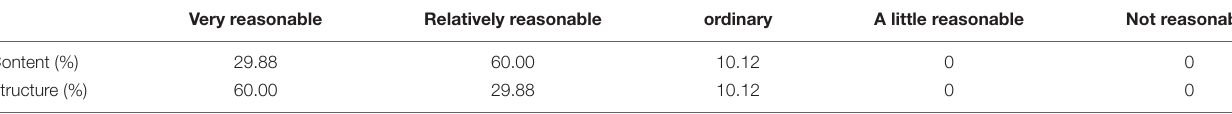
TABLE 1 | Experts’ overall evaluation of the questionnaire content and structure.